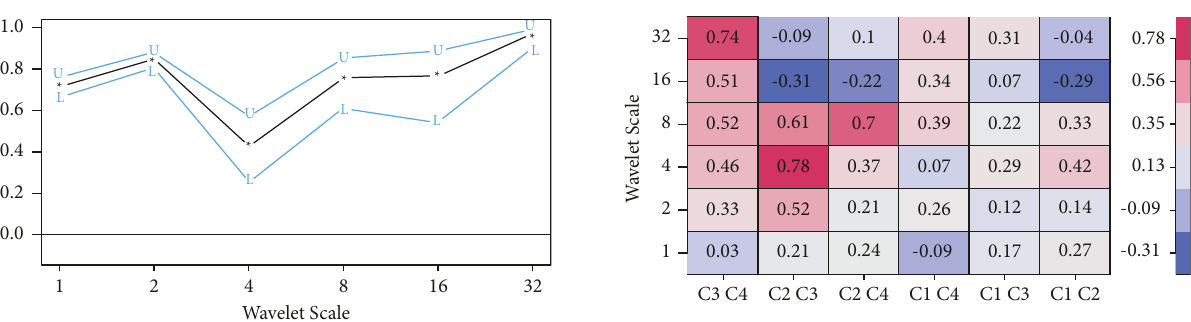
Figure 3: Wavelet multiple correlation between systematic risk of Africa and Middle East (18/08/2010–03/11/2020). The blue lines denote upper (U) and lower limits (L) of the 95% confidence interval, respectively.